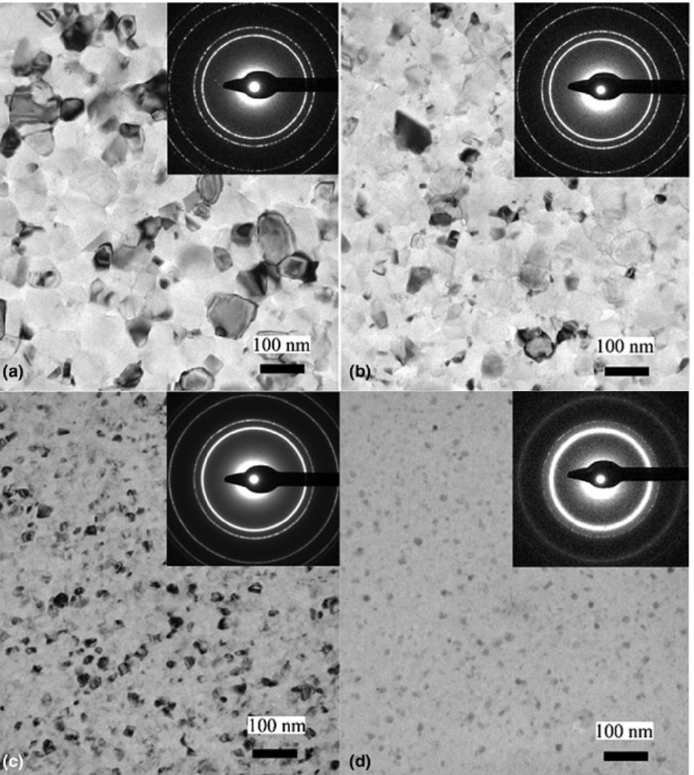
Figure 7. TEM images with SAED insets of ( a ) pure Al, ( b ) Al–1% Mg, ( c ) Al–10% Mg, and ( d ) Al– 30% Mg films, showing microstructures with very fine grain sizes decreasing with an increasing Mg content. The films exhibit fcc Al(Mg) phase at each composition up to 30% Mg, at which point an amorphous component becomes dominant. Reproduced with permission from [31]. Copyright © 2019, The Materials Research Society.